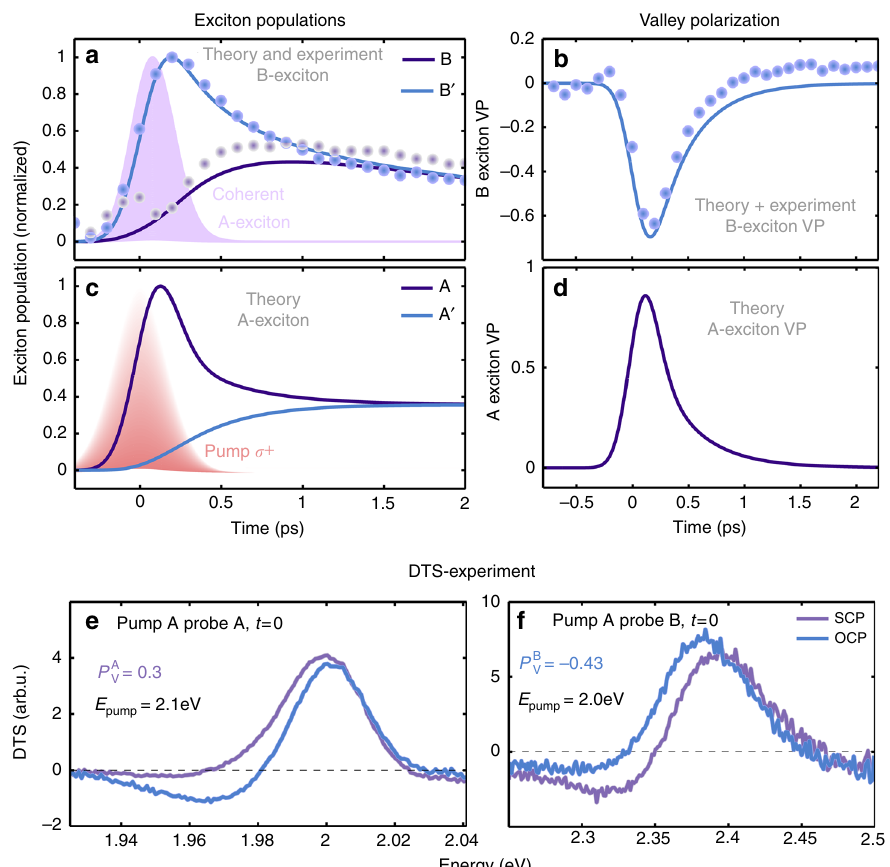
Fig. 2 Exciton population and valley polarization. Temporal evolution of the exciton population and the resulting valley polarization (VP) of B excitons ( a , b theory – experiment comparison) and A excitons ( c , d theoretical calculation) after resonant excitation of A 1s exciton in the K valley. The optically driven coherent A excitons couple via Dexter interaction to the B ′ excitons in the unpumped K ′ valley (see also Fig. 1). This coupling dominates the B exciton dynamics and instantaneously induces B ′ exciton populations ( a ) and as a result a negative valley polarization ( b ) which decays within 0.5 picoseconds. c During the pump pulse (red-shaded area), A excitons are generated, which induce A ′ excitons via electron-hole exchange interaction. d The corresponding optically induced valley polarization of A excitons (near-resonant experimental data in the SI). e , f Polarization dependent pump-probe measurement showing the OCP (opposite circular polarization) and SCP (same circular polarization) signal of the A 1s and B 1s excitons, for pumping the A 1s exciton close to the